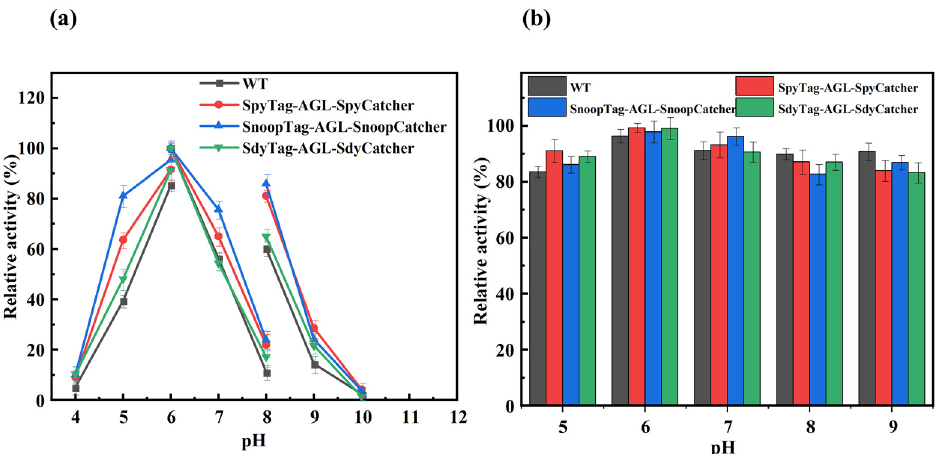
Figure 6. Effects of pH on the activity and stability of wild-type and cyclized AGL: ( a ) optimal pH, ( b ) pH stability. All assays were performed in triplicate, and the standard deviations of biological replicates are indicated by error bars.